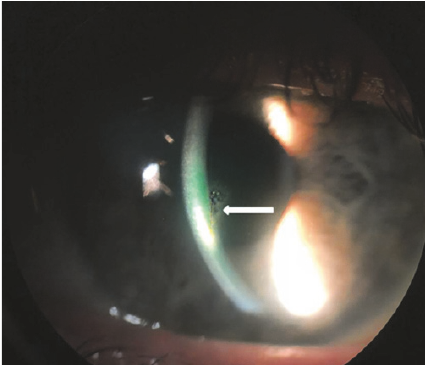
Figure 1: Slit lamp photograph of the left eye demonstrating a single hair embedded within the central cornea (white arrow) with surrounding stromal haze.